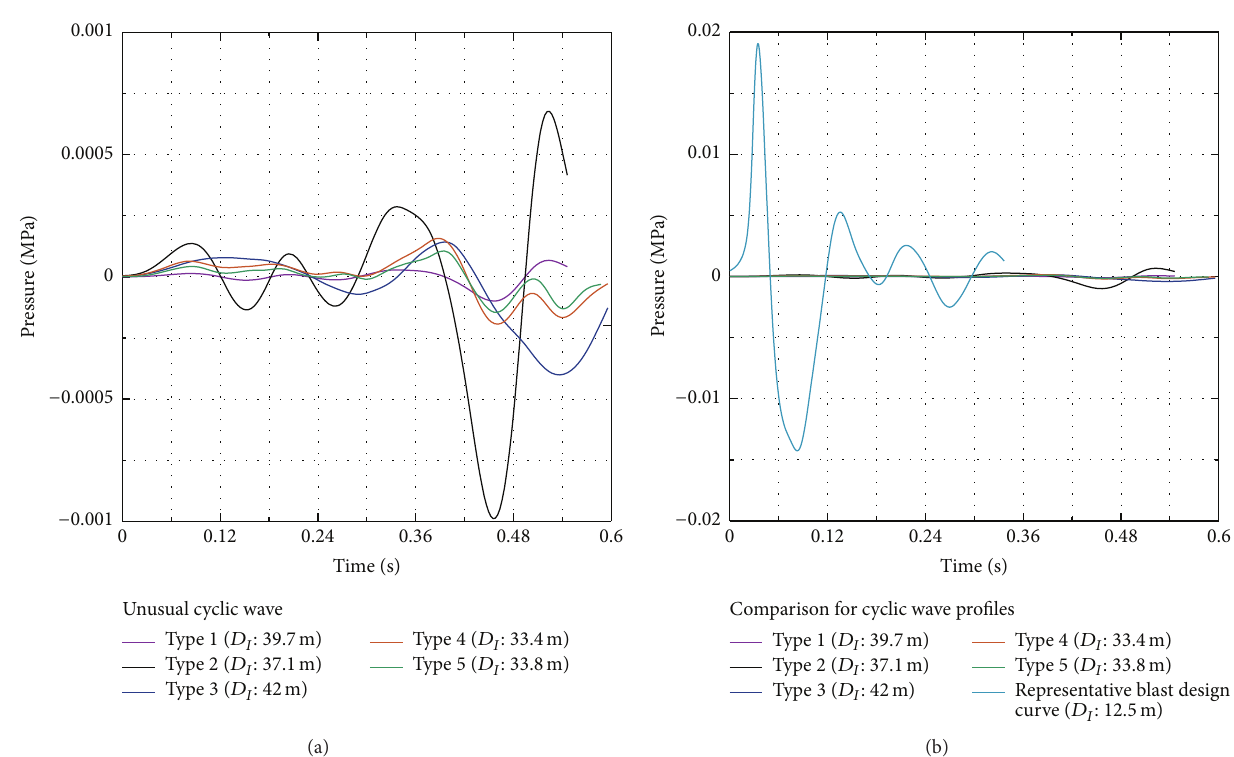
Figure 10: A variety of cyclic types in blast wave profiles. (a) In small pressure range. (b) Representative blast wave of cyclic